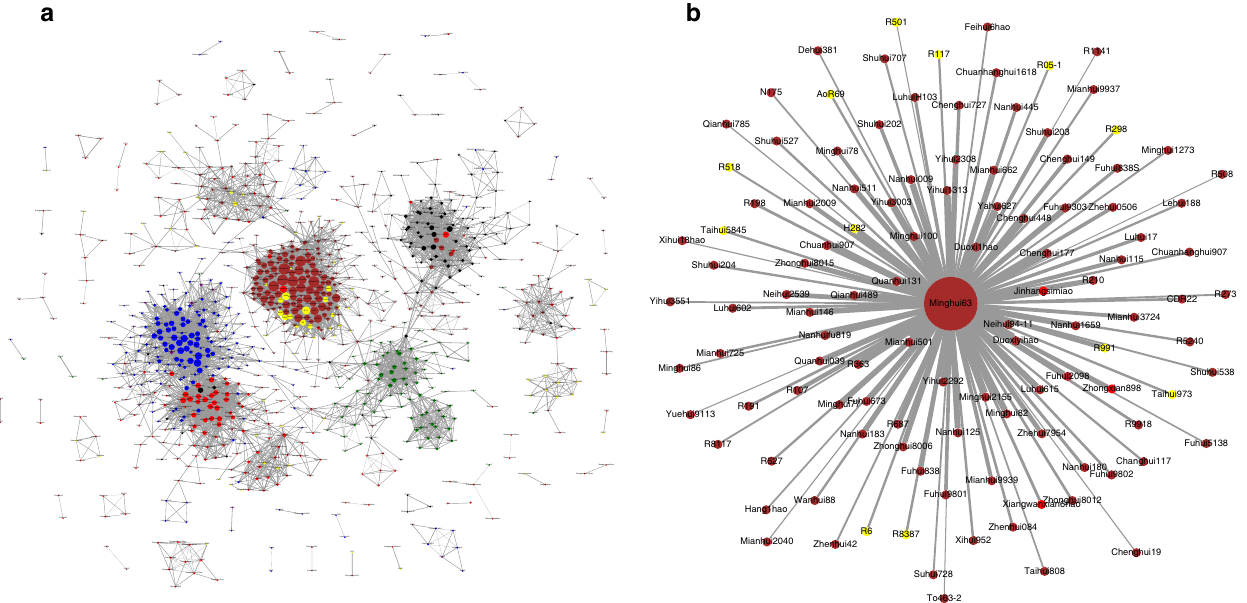
Fig. 1 Kinship relationships among accessions. a All kinship relationships with kinship coef fi cients greater than 0.45. Of 1143 accessions, 992 formed 50 multiple-member clusters and 7376 relationships. The remaining 151 accessions did not have any relationship above the cut-off value and thus are not shown. The largest cluster contains 772 accessions and several subclusters. b Minghui63 and 113 related accessions with kinship coef fi cients greater than 0.45. In both a and b : circle sizes represent the degree of relationship, i.e., the number of lines connected to each circle; line widths are based on the coef fi cients between two accessions; circles are in red for conventional rice (CR), yellow for 2-line restorers (2R), green for 2-line photoperiod genic and thermosensitive male sterile (GMS) lines, blue for 3-line cytoplasmic male sterile (CMS) lines, brown for 3-line restorers (3R), purple for 3-line maintainers (3M), and black for germplasm rice (GR). Source data are provided as a Source Data fi